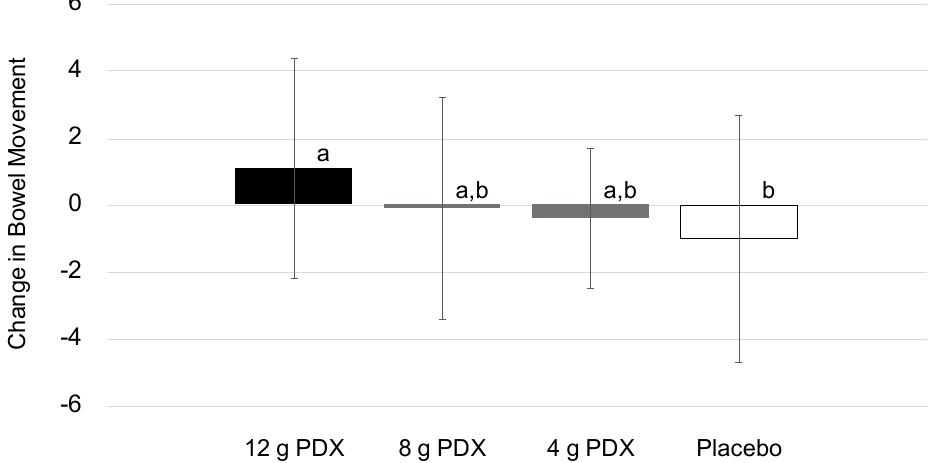
Figure 3. Changes in bowel movement from the baseline (Day 0) to the end of intervention (Day 14) ( p = 0.017). Bars with letters are significantly different after Dunnett’s correction ( p ≤ 0.05). PDX—polydextrose.